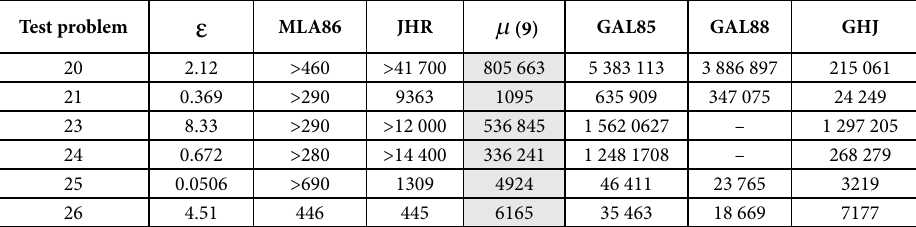
Table 4. The numbers of function evaluations for n =